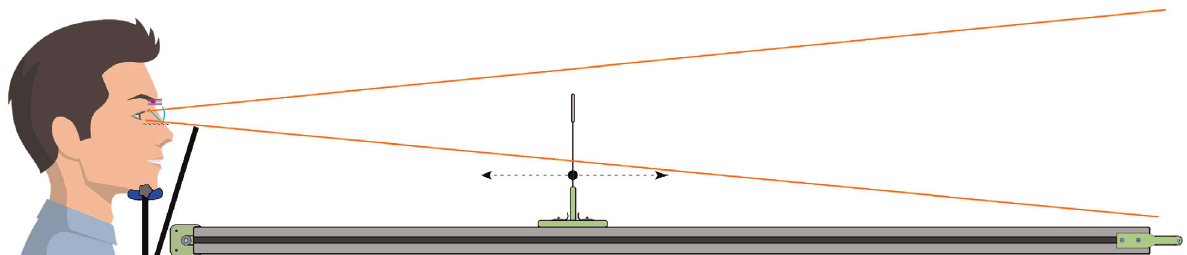
Fig. 1. The schematic of the experimental setup. The participant with a headset sat in front of the linear stage (total length – 2.4 m). The shading plane was used to block the view of the linear stage. The linear stage was equipped with the sliding carriage, which held a physical pointer on a thin pole.